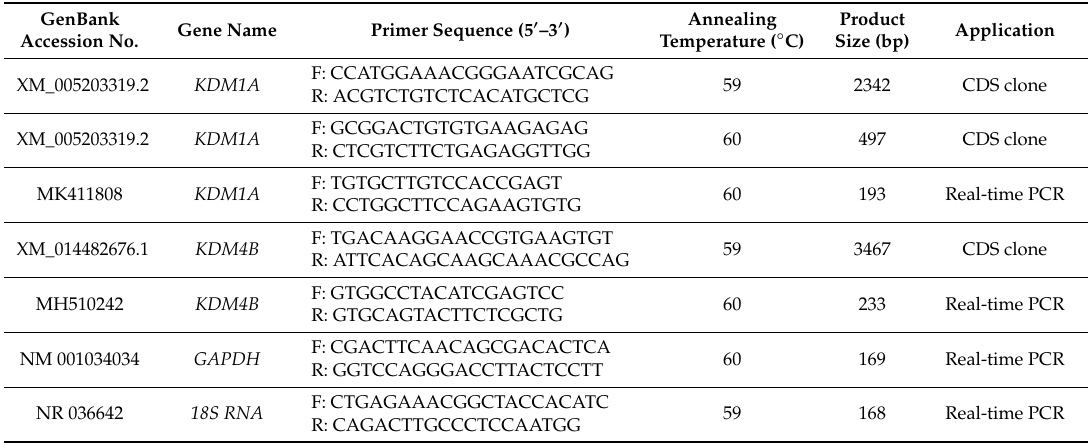
Table 1. Primers and conditions used for cloning and Real-time